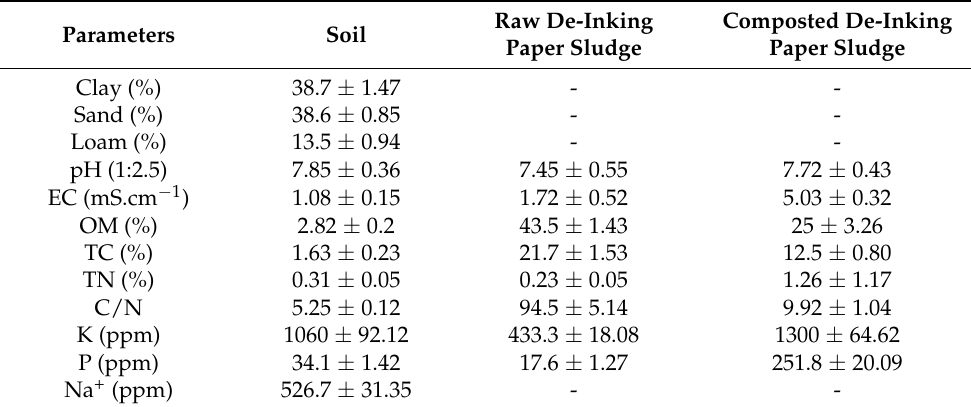
Table 1. Physical and chemical characteristics of the experimental soil and the de-inking paper sludge used in this